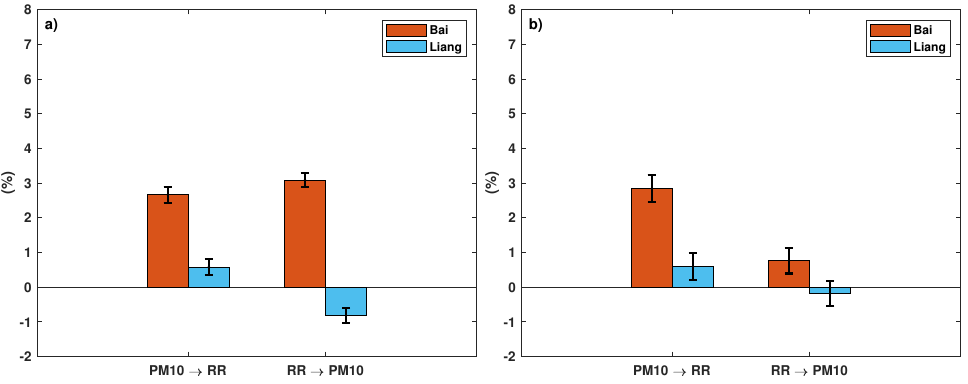
Figure 6. Relative information flow from PM 10 to RR and RR to PM 10 using Bai ( τ B , in orange) and Liang ( T L , in blue) methods for ( a ) low (October to April) and ( b ) high (May to September) dust seasons over 11 years. The standard error (95% significance level) is represented by the